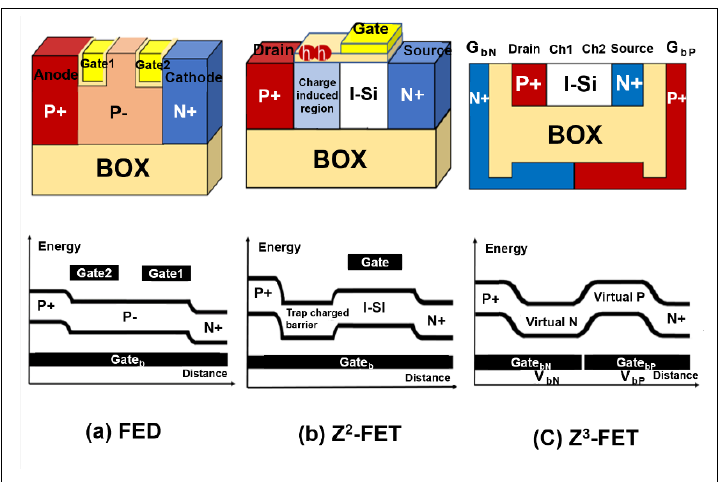
Figure 5. Structure and energy band diagram for band-modulation devices: ( a ) FED (field effect diode), ( b ) Z 2 -FET (zero-impact ionization and zero subthreshold swing FET), and ( c ) Z 3 -FET (zero subthreshold swing, zero-impact ionization, and zero gate FET) with bias for virtual potential barriers [19].